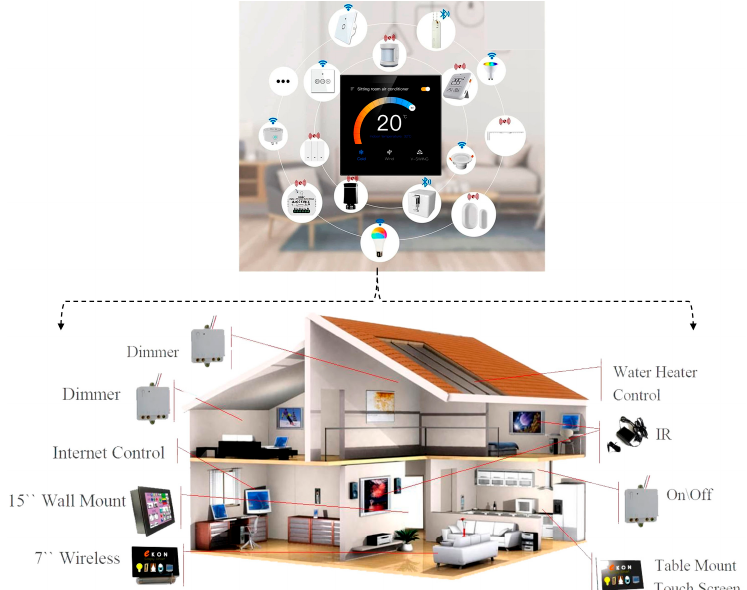
Figure 1. The smart home control system .